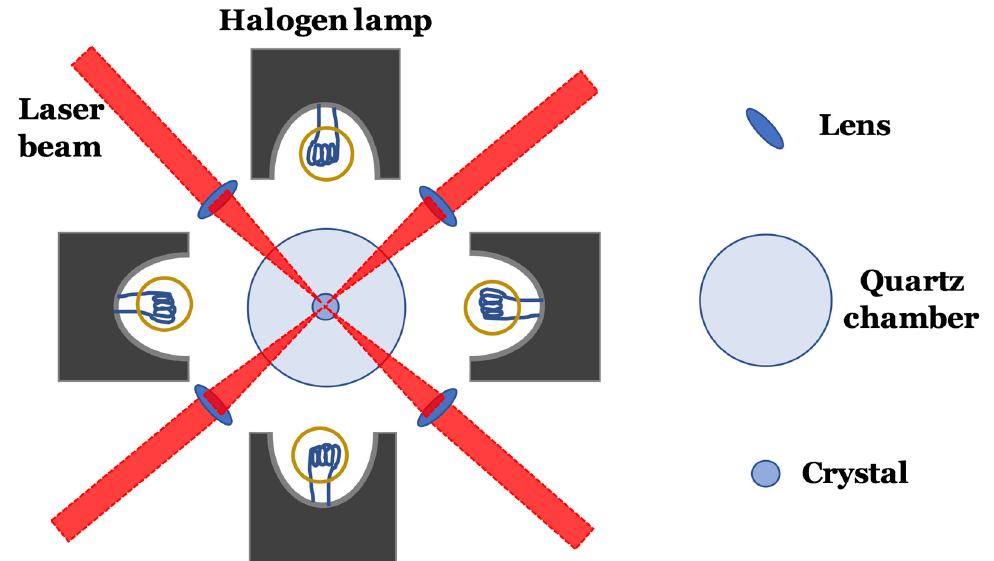
Figure 3. Top-view schematic drawing based on the hybrid Laser Floating Zone designed